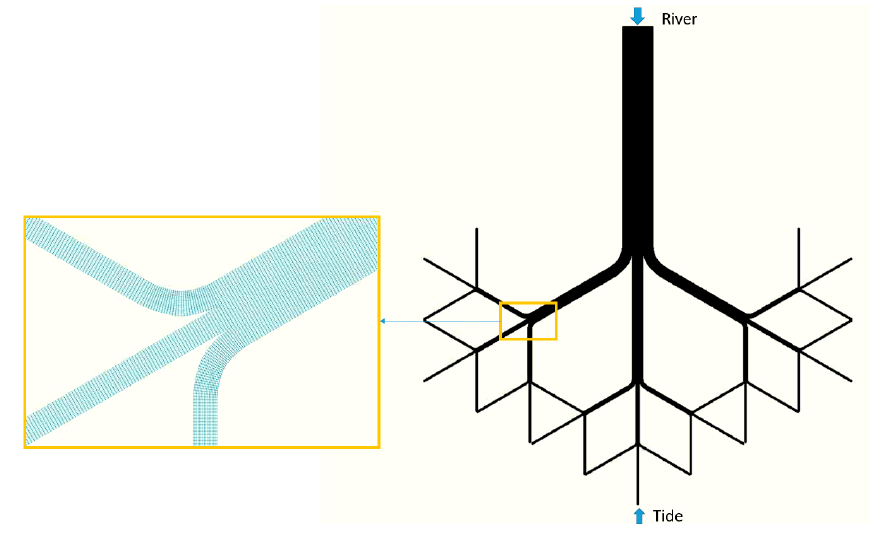
Figure 6. An unstructured mesh generated for L3a.